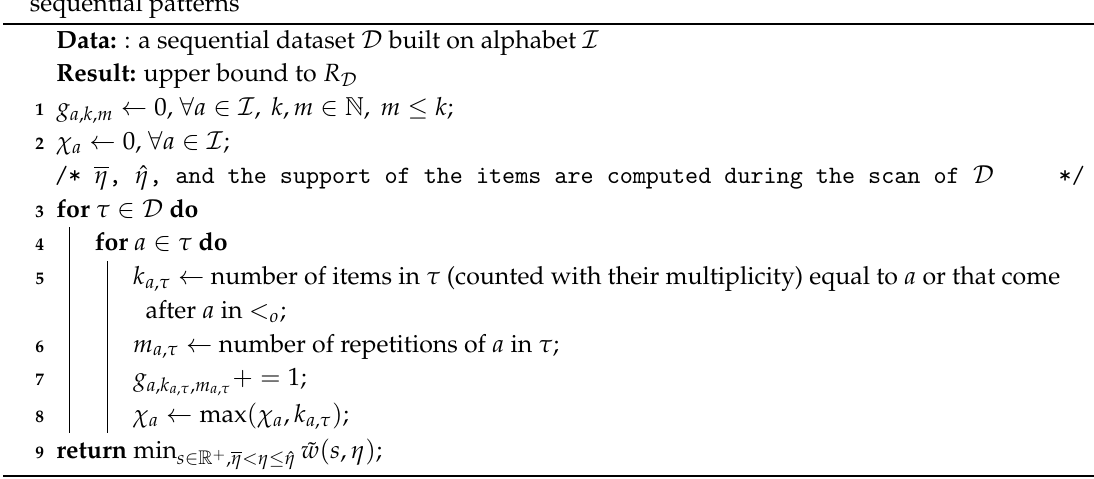
Algorithm 4: RadeBound( D ): algorithm for bounding the empirical Rademacher complexity of sequential